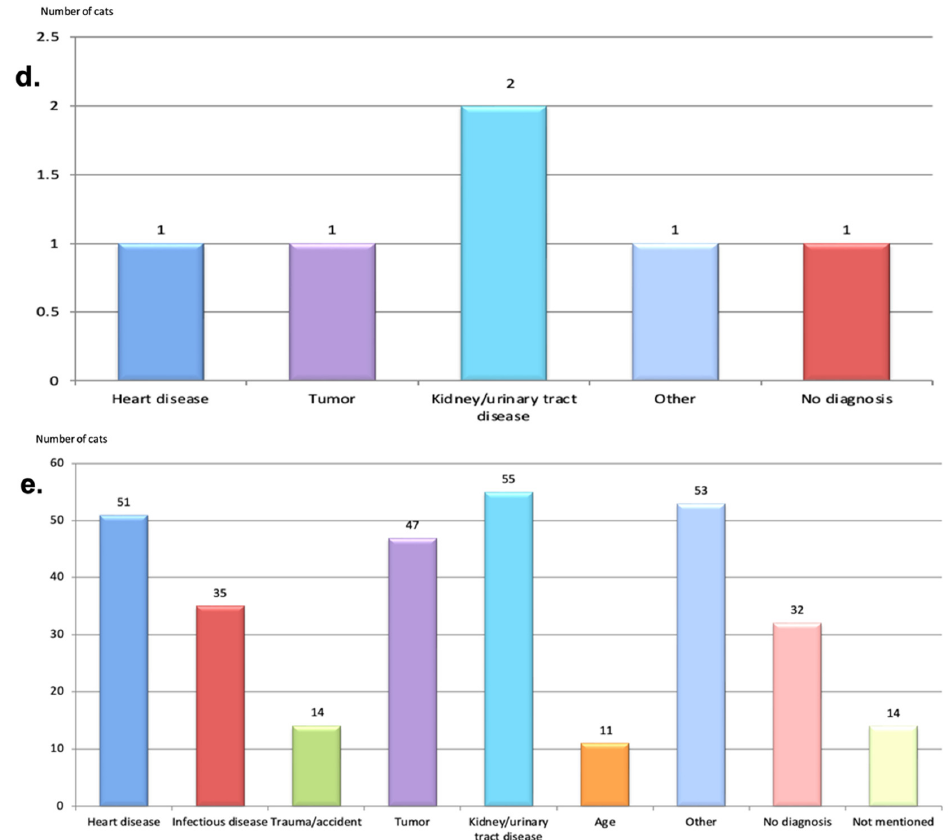
Figure 6. ( a ) The proportional mortality in deceased Screen N cats (n = 260), ( b ) The proportional mortality in deceased Screen EQ cats (n = 15), ( c ) The proportional mortality in deceased Screen FCM cats (n = 31), ( d ) The proportional mortality in deceased Screen Other cats (n = 6), ( e ) The proportional mortality for all deceased breed-screened cats (n = 312). Examples of “other” diseases includes chronic eye disease, spondylosis, allergy, epileptic seizures, surgical disease. Screen N = Cats classi- fied as normal at breed-screening, Screen EQ = Cats classified as equivocal at breed-screening, Screen FCM = Cats diagnosed with HCM or RCM at breed-screening, Screen Other = Cats classified as Other at breed-screening.